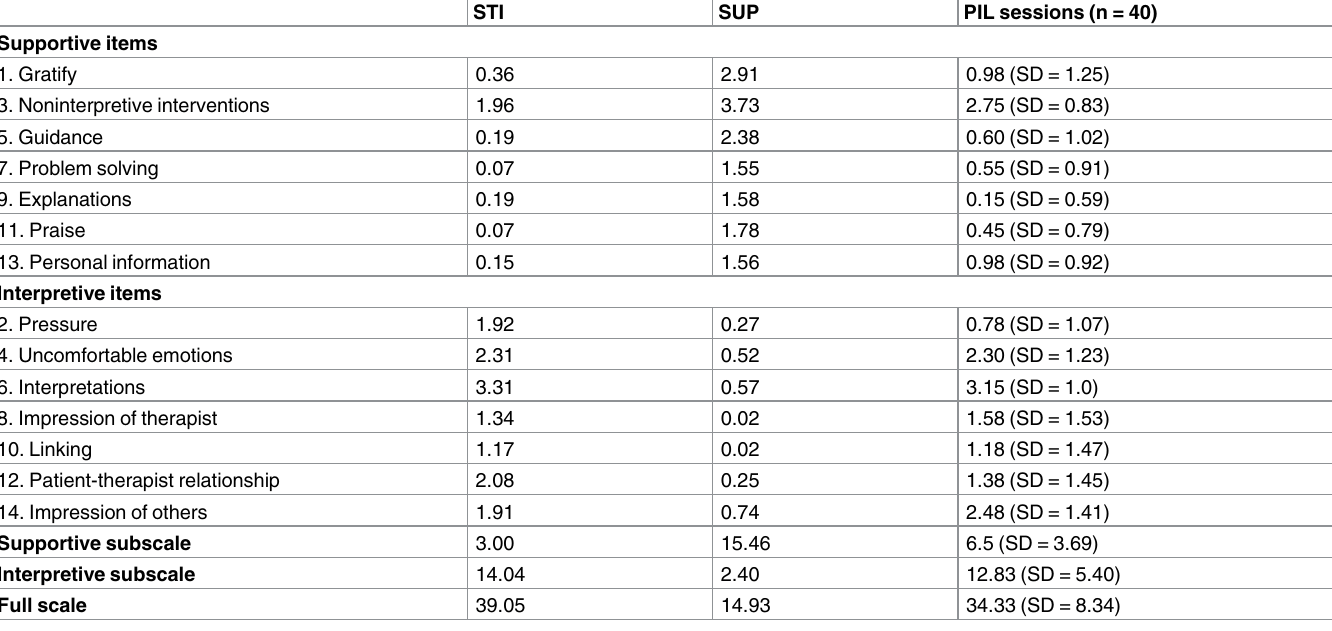
Table 1. Comparison of mean ratings for the items, subscales, and the full ISTS scale according to different treatment modalities and PIL